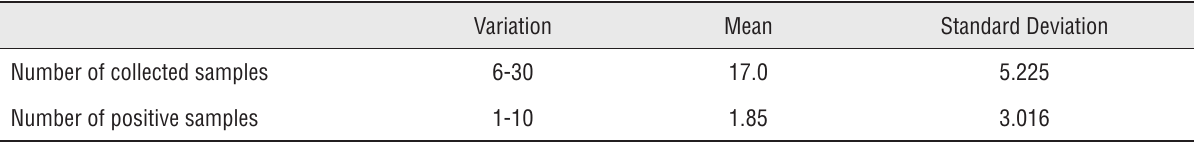
Table 1 - Numerical characteristics of prostate biopsies of 77 patients.